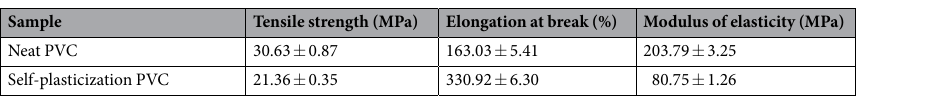
Table 3. Tensile data of PVC